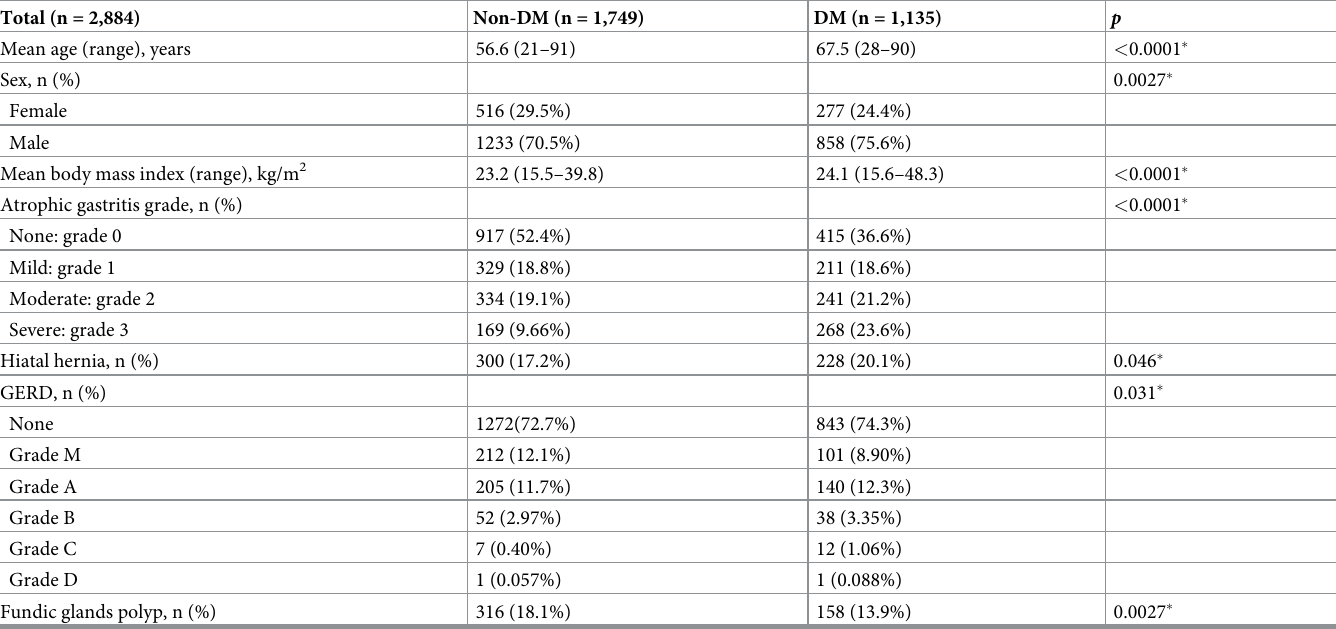
Table 1. Demographic data of non-DM and DM patients.